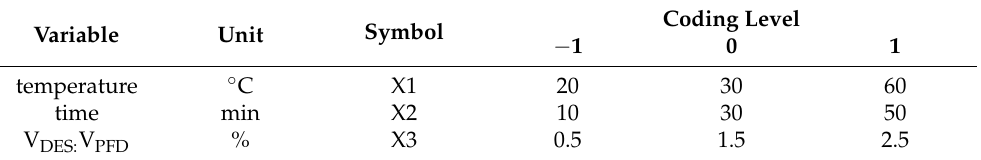
Table 8. The range of experiment and the statistically significant